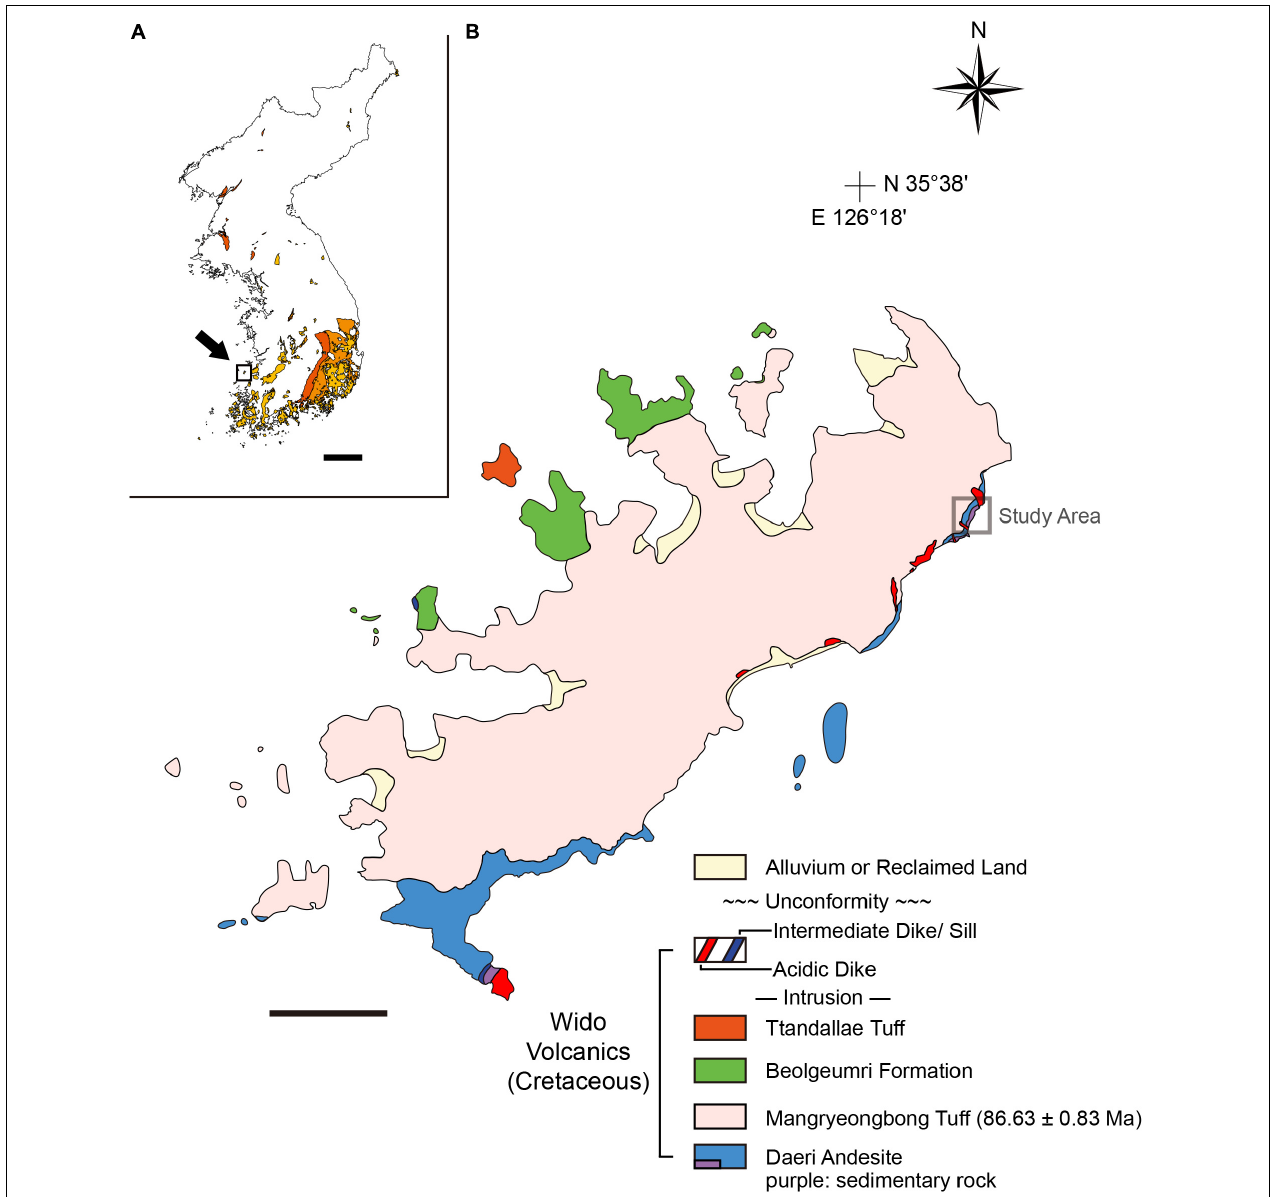
FIGURE 1 | Geological map of Wi Island, South Korea. (A) A map of the Korean Peninsula and distribution of the Cretaceous basins (colored regions). Note that Wi Island (inset square) is a part of volcanic-influenced sedimentary successions colored in yellow. Modified from Choi and Lee (2017). (B) A geological map of Wi Island. The Wido Volcanics is composed of four conformable units: Daeri Andesite, Mangryeongbong Tuff, Beolgeumri Formation, and Ttandallae Tuff in ascending order (Ko et al., 2017). Modified from Koh et al. (2013), Ko et al. (2017), and Choi and Lee (2019). Scale bars equal 100 km (A) ; 1 km (B)